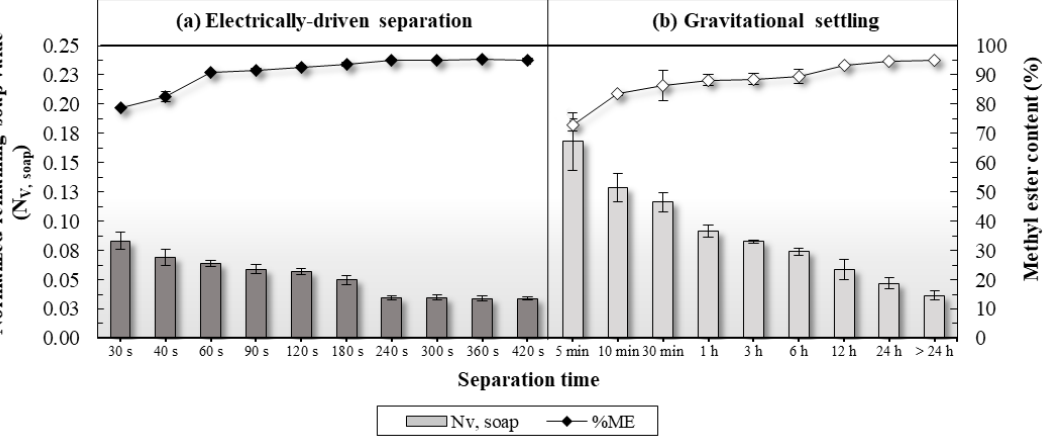
Figure 17. Effect of methyl ester (%ME) and normalized remaining soap content (N V, soap ) by com- paring the separation performance between the GS and EDS process using iron (Fe) point-to-point electrodes, with a vertical distance between electrodes of 3 cm and applied AC voltage of 3 kV.